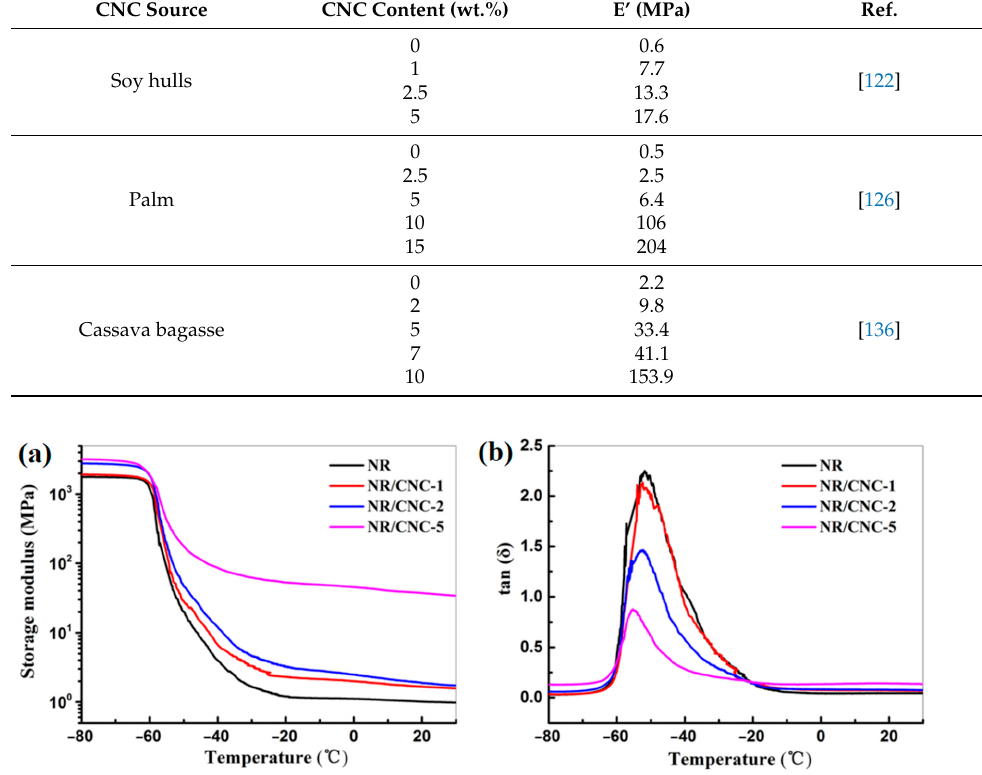
Figure 13. Effect of nanocellulose content on ( a ) storage modulus and ( b ) tan δ as a function of temperature (tests performed at 1 Hz) (reproduced with permission from [138]).